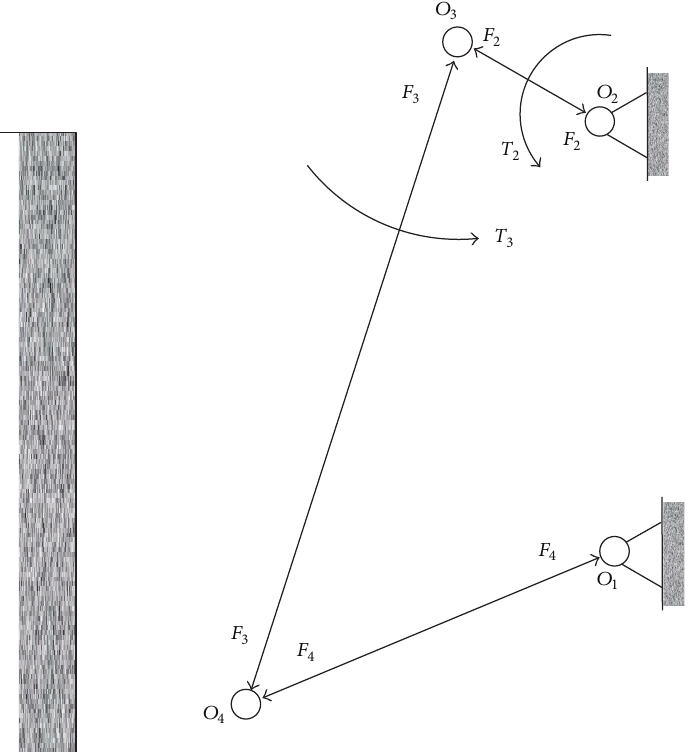
Figure 2: Model for static force analysis of the single toggle jaw